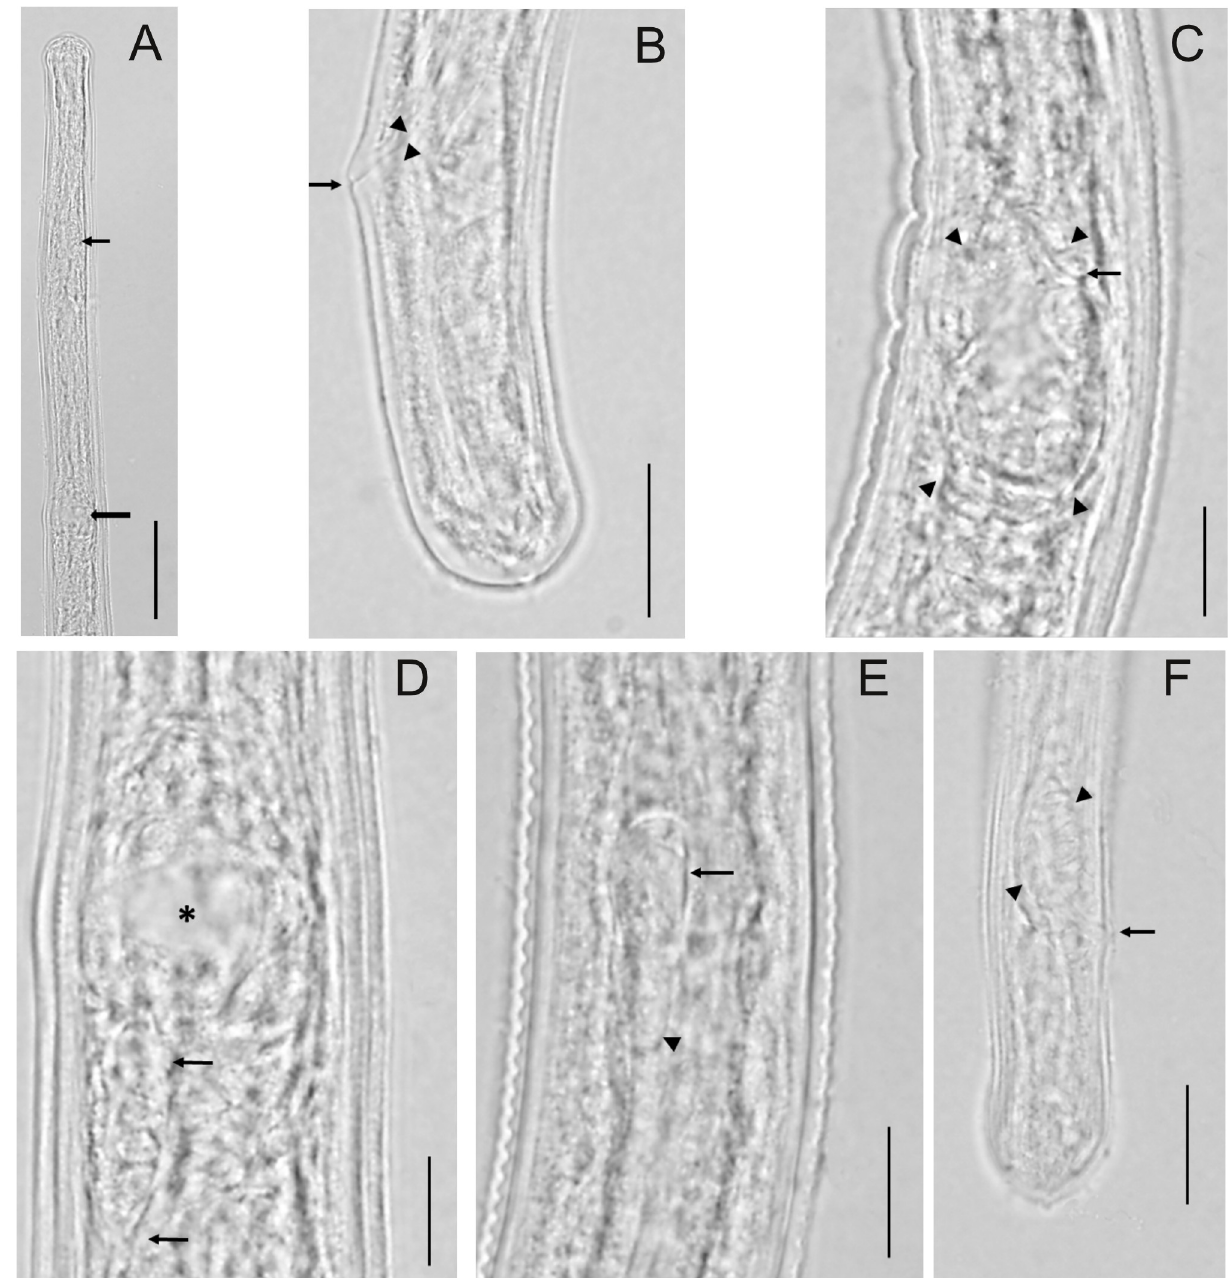
Fig 3. Imaging of O . volvulus larvae recovered from various models. A) Anterior end of female larva showing overall shape, location of nerve ring (small arrow) and vulva (large arrow). [Scale bar = 50 μ m] B) Female tail, lateral view, showing overall shape and rectum (arrow heads) and anal opening (arrow). [Scale bar = 15 μ m] C) Developing ovejector (arrowheads), lateral view, showing attachment to body wall and beginning of vulva (arrow). [Scale bar = 10 μ m] D) Developing ovejector, dorsal-ventral view, showing the relative large cavity (asterisk) and the developing tube (arrows). [Scale bar = 10 μ m] E) Male larva at approximately mid-body showing the testis (arrow), which is C-shaped, curved posteriorly, and has begun to grow posteriorly (arrowhead). [Scale bar = 10 μ m] F) Male tail, lateral view showing overall shape. One developing spicule pad (arrowheads) is clearly visible as is the anal opening (arrow). [Scale bar = 15 μ